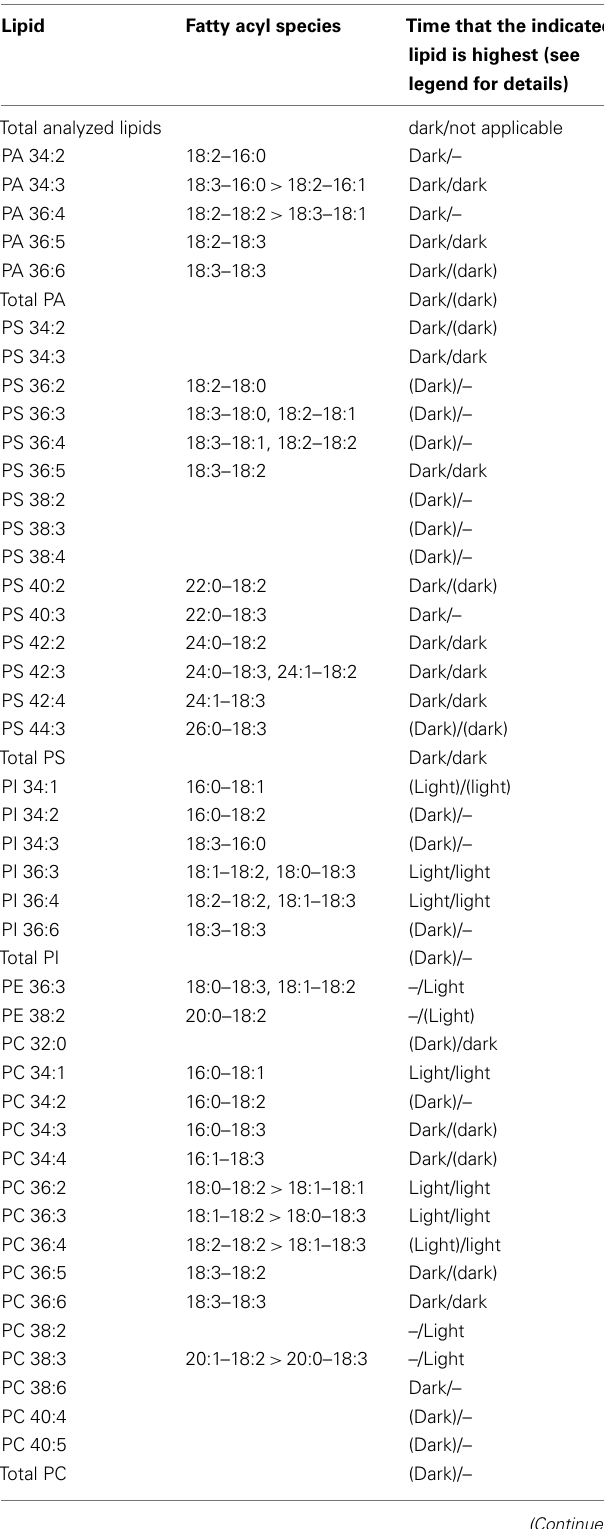
Table 1 | Polar lipid molecular species significantly changed at end of dark or light period.